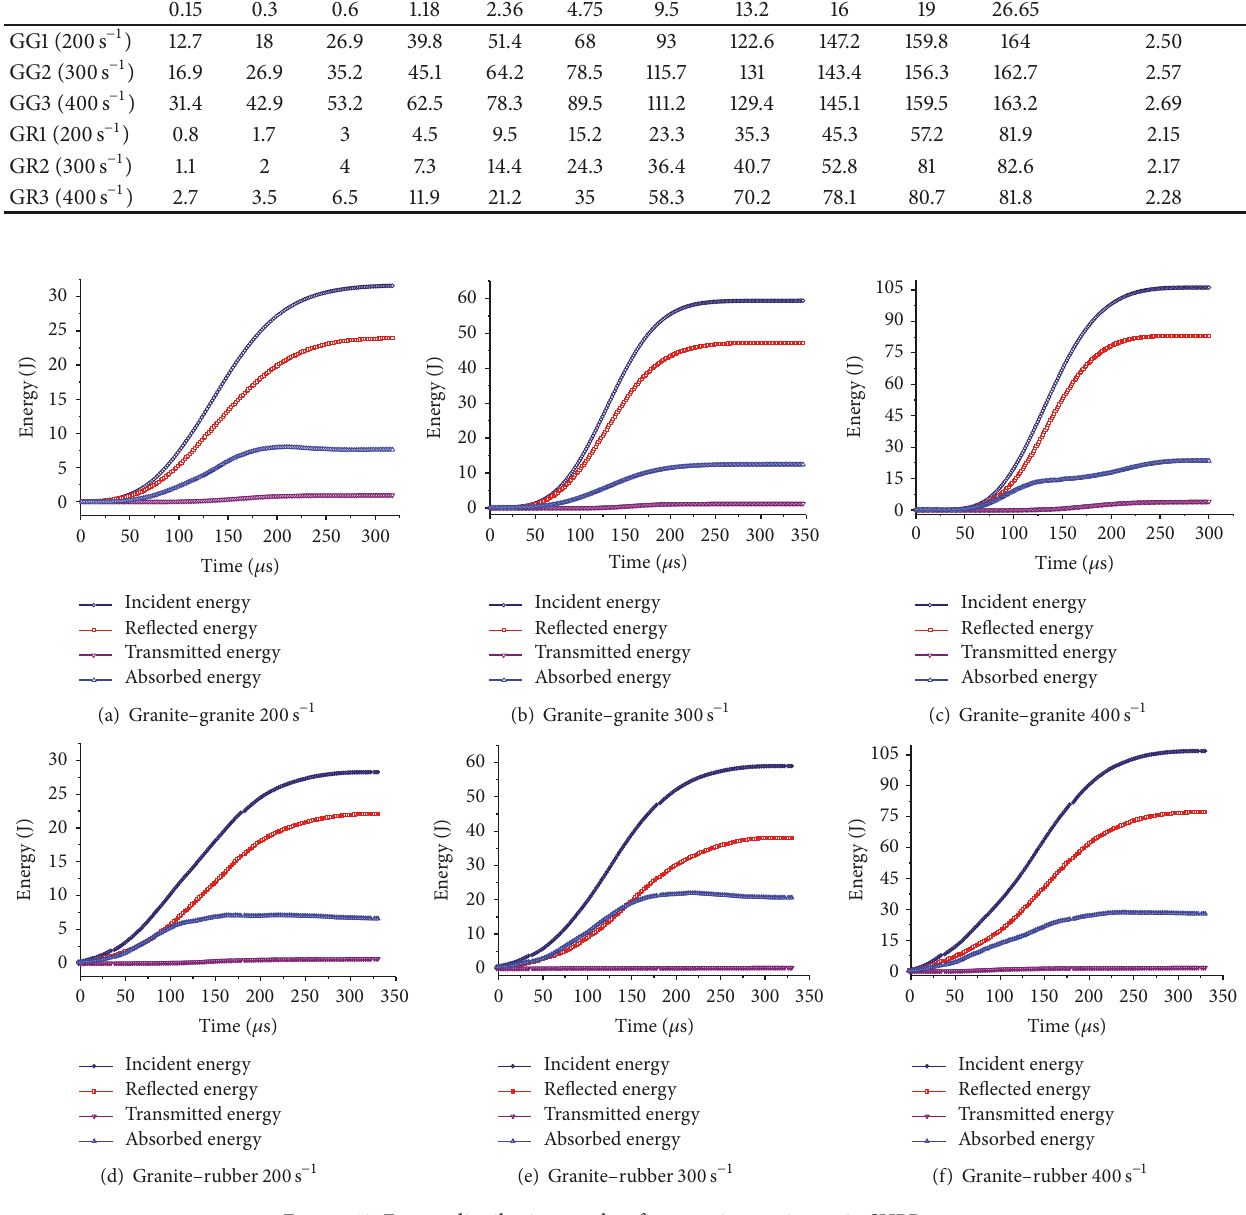
Figure 12: Energy distribution results of composite specimens in SHPB